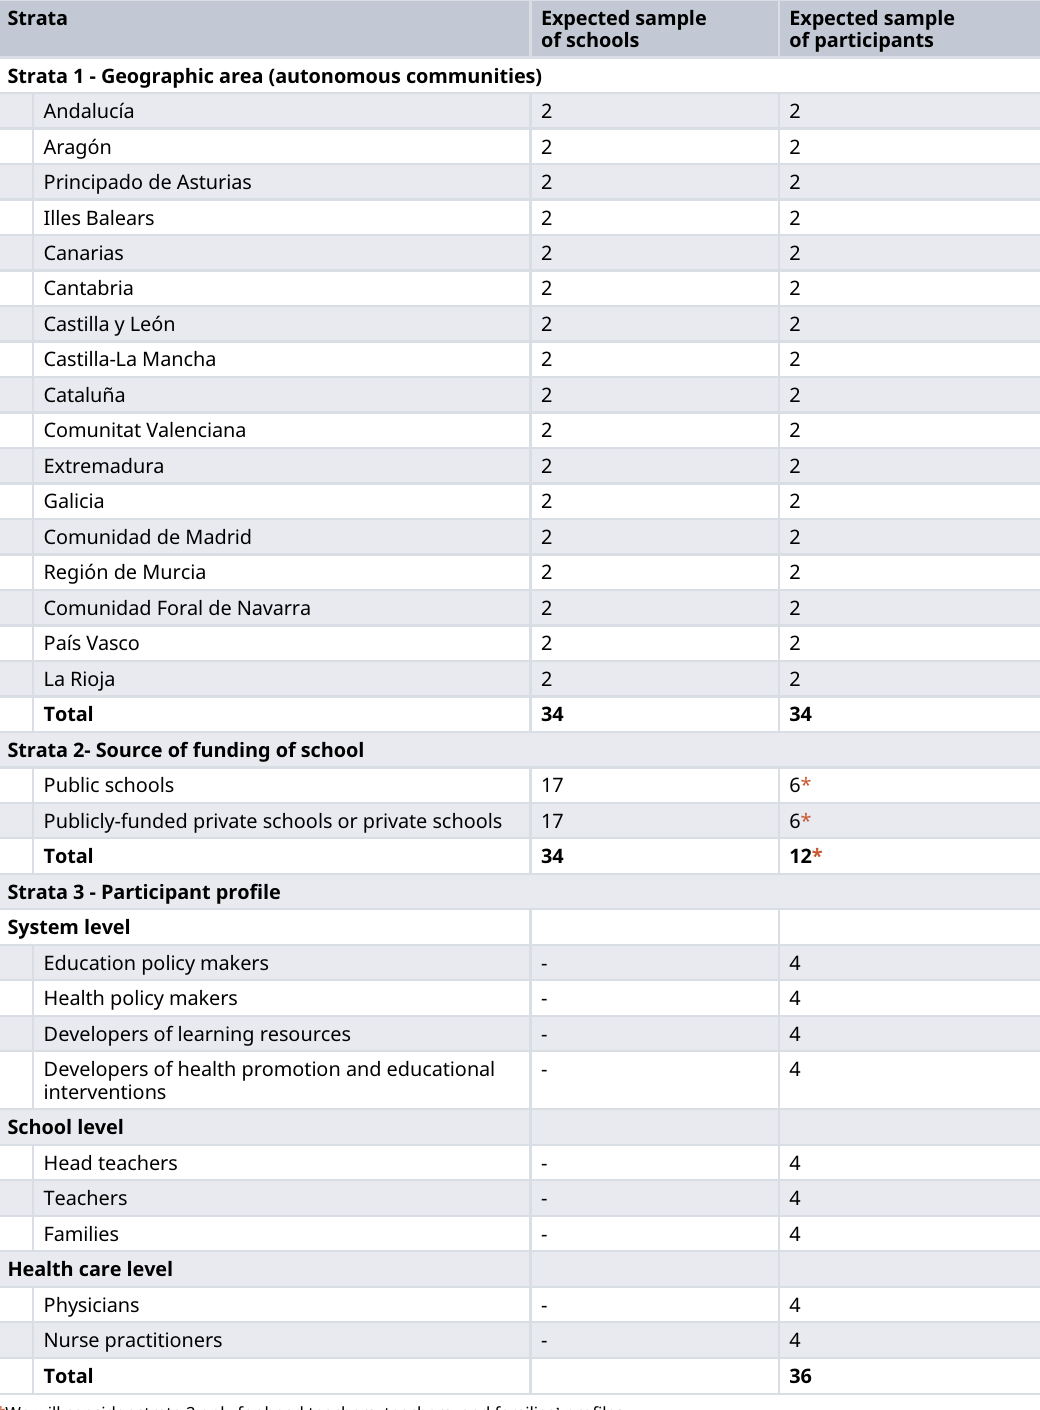
Expected sample of schools of